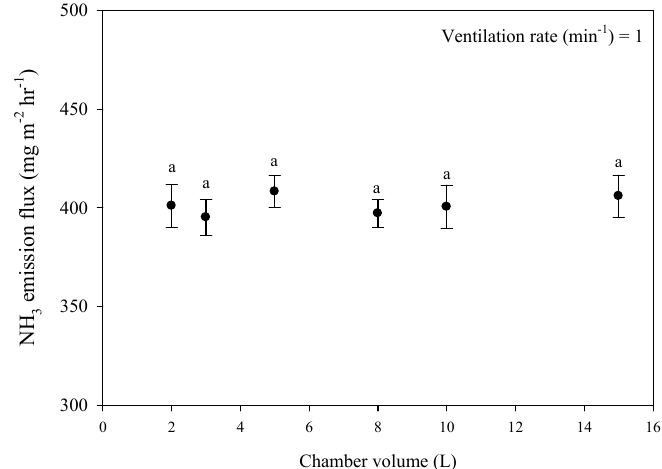
Figure 5. Changes in ammonia emission flux according to volume of chamber using dynamic chamber-capture system at 20 °C condition with ventilation rate fixed at 1 min − 1 . Means with different letters are significantly different (Tukey’s test, p < 0.05). Error bar means standard deviation (SD, n = 3).